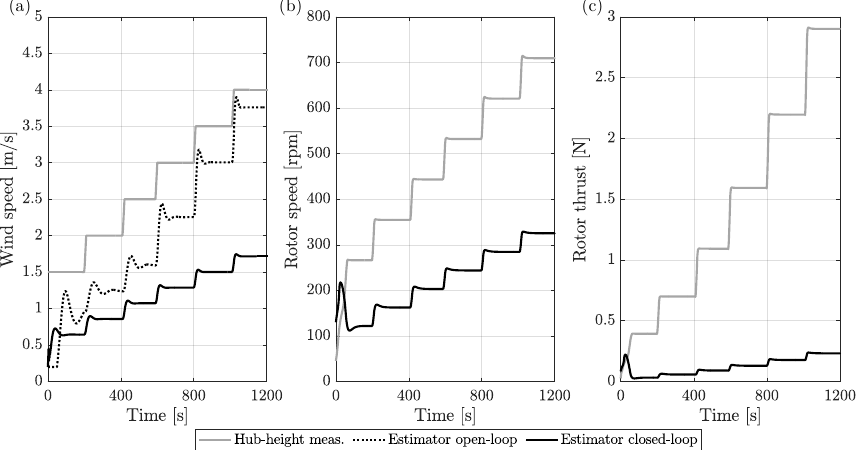
Figure 7. Turbine response to step wind with TSR tracking with different feedback signal: hub- height measurement, and rotor-effective value estimated with the Immersion & Invariance algorithm. ( a ) Wind speed signals. ( b ) Rotor speed. ( c ) Rotor